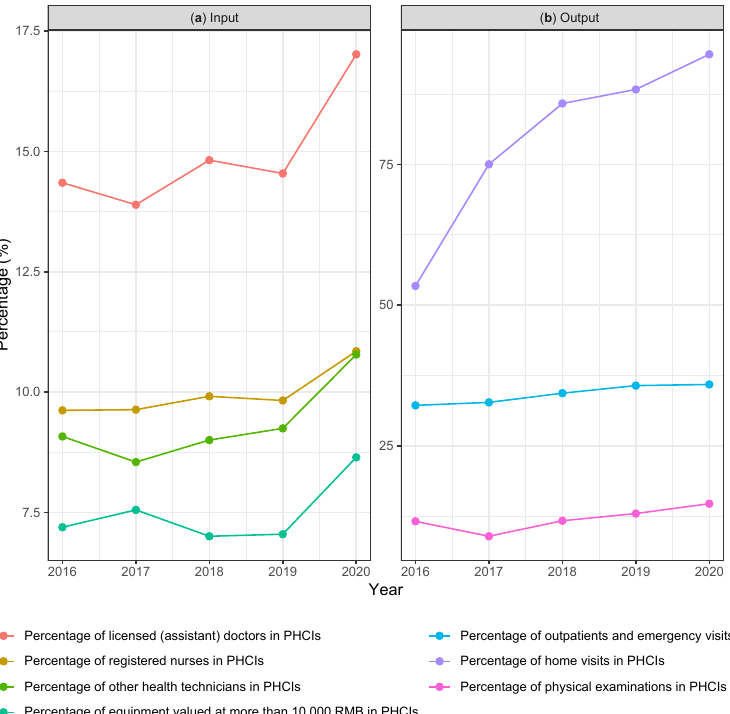
Figure 1. The percentage of volume of comparable input and output variables contributed by PHCI in Shenzhen from 2016 to 2020. ( a ) Percentages of input variables. ( b ) Percentages of output variables.